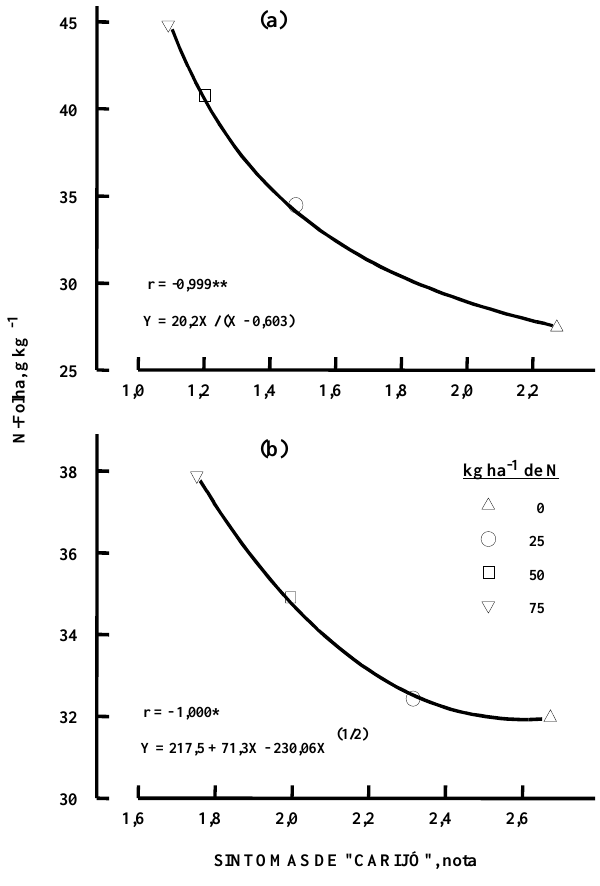
Figura 3. Relação entre a concentração de N-foliar e a intensidade do “carijó”, considerando as médias obtidas por nível de adubação nitrogenada do algodoeiro em cobertura, em Mococa (a) e Tatuí (b),